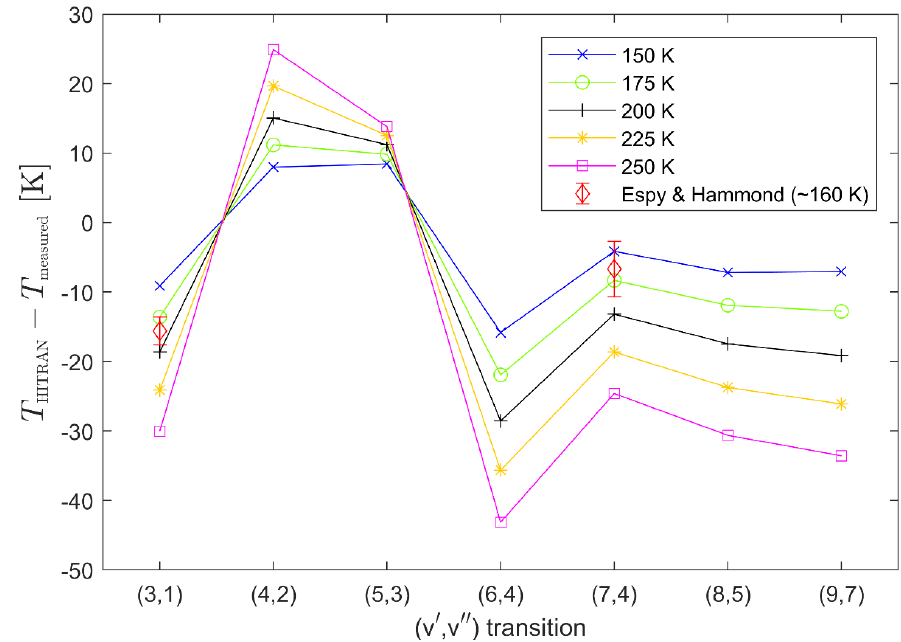
Figure 5. Difference between the temperature of the fit with HITRAN coefficients and the temperature of the synthetic spectrum created with the coefficients measured in this study plotted as a function of upper vibrational level v’ for a range of synthetic spectra temperatures between 150 and 250 K. The two red diamonds represent fits to data from Espy and Hammond